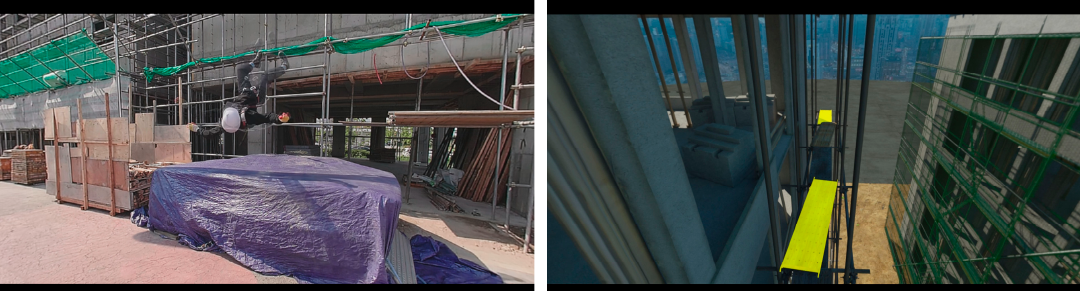
Figure 2. Example VR screenshot of the scaffolding task safety training (Source ref [51], 2019, Korea Occupational Safety & Health Agency).